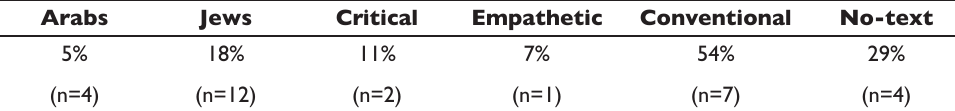
Table 2: Discussantsanddiscussiongroupsmakingreferencetoholyscriptures,byethnicgroupand